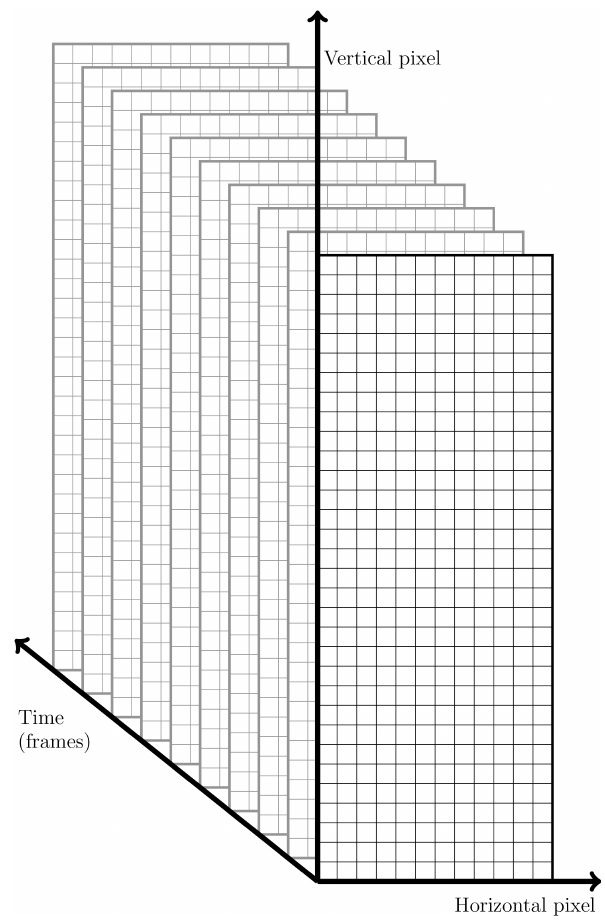
Figure 2. Schematic drawing of a